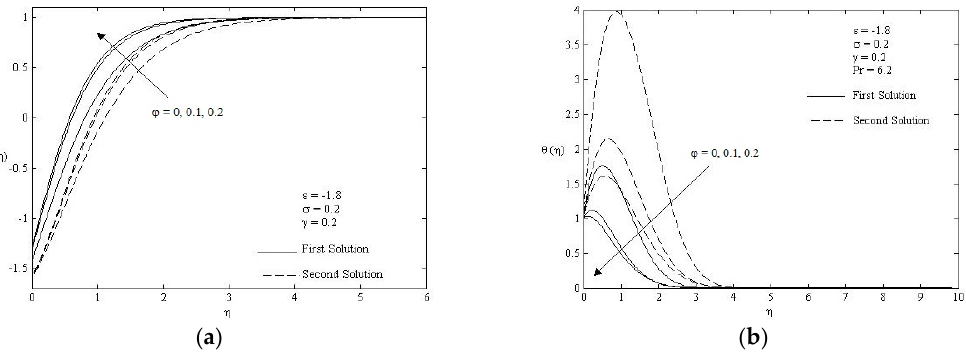
Figure 7. Dual velocity f (cid:48) ( η ) ( a ) and temperature profile θ ( η ) ( b ) for particular values of ϕ